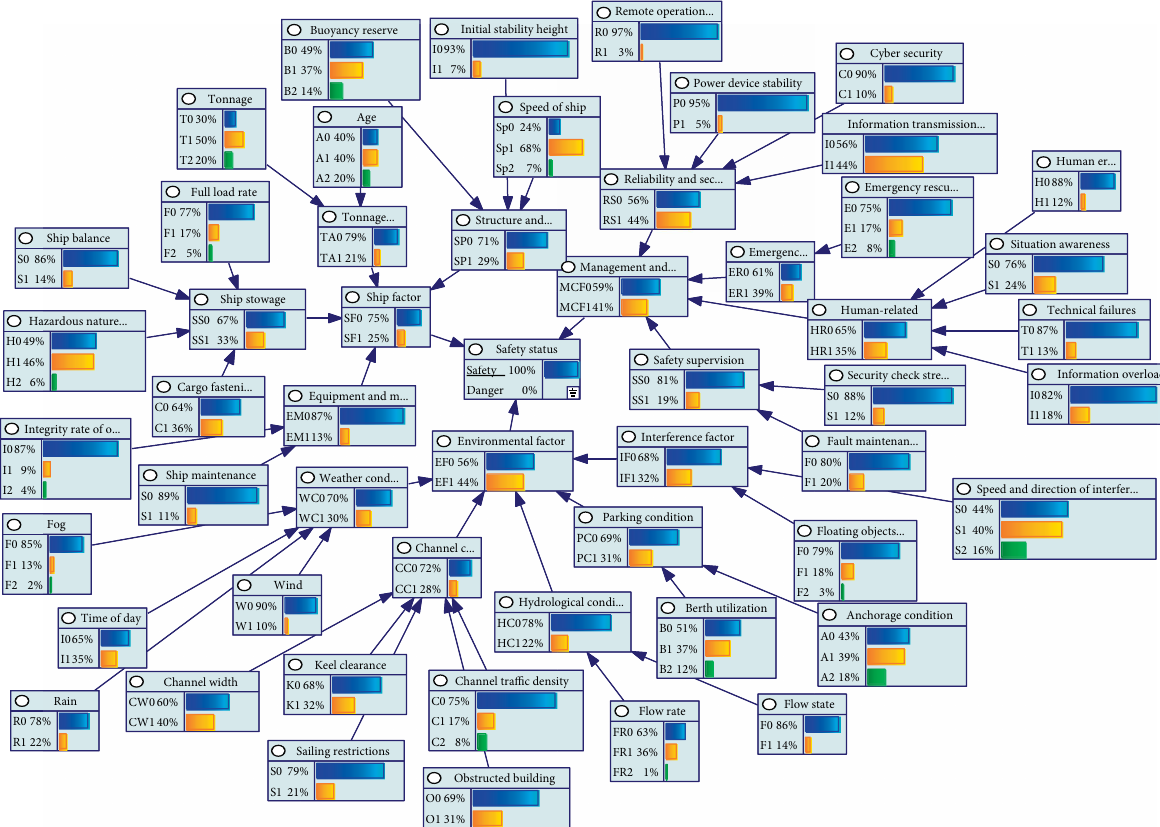
Figure 5: Reverse reasoning learning